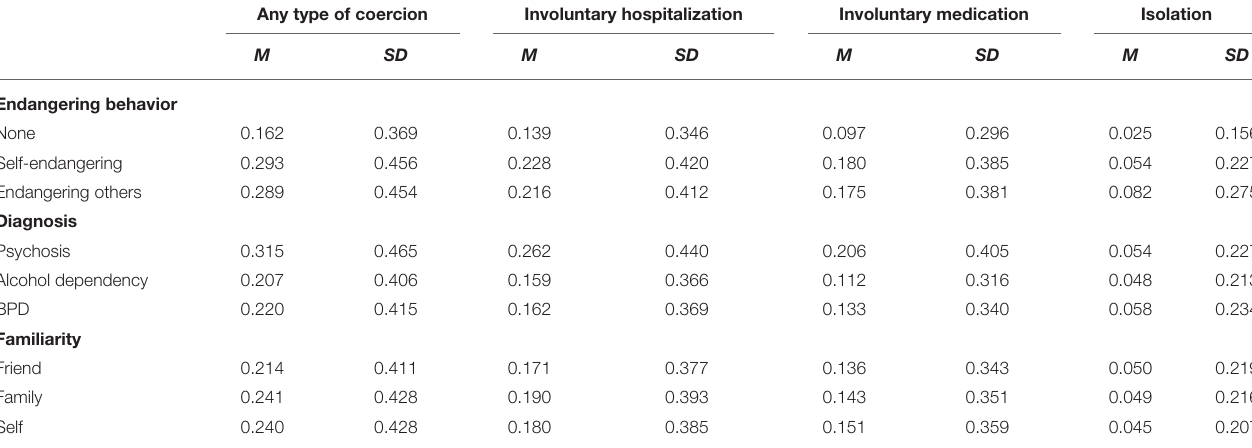
TABLE 1 | Mean ( M ) and standard deviation ( SD ) for endangering behavior, diagnosis and familiarity in dependence of coercive measures.